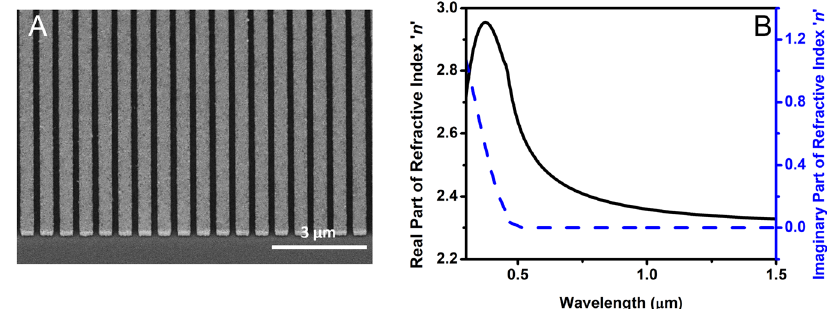
Fig. 2 The designed metasurface and refractive index of As 2 S 3 . A The 30-degree tilted SEM image of the patterned As 2 S 3 structure on a glass substrate. B The real and imaginary part of the refractive index of a 300-nm-thick As 2 S 3 thin fi lm was measured using spectroscopic ellipsometry (Cauchy model). The absorption coef fi cient signi fi cantly increases for wavelengths below 500 nm.